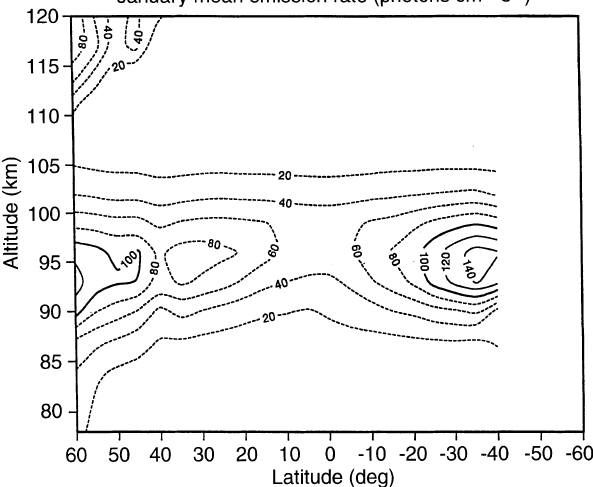
Fig. 11. Latitude-height distribution of the mean green-line emission rate